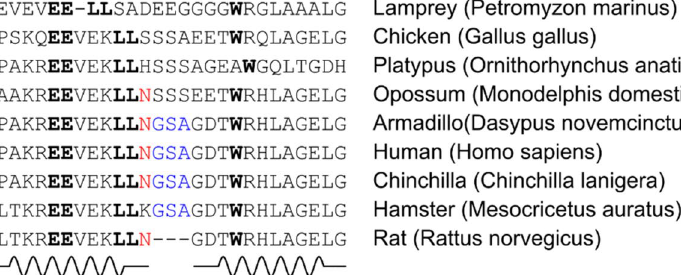
Figure 8. Sequence alignment of death domain fragments from different organisms. The highly conserved residues are in bold. The N352 is shown by red, GSA sequence by blue. The secondary structure of the rat p75NTR is shown under amino acid sequences. The phylogenetic tree (right) shows the evolutionary history of the DD fragment of the p75NTR gene, the numbers indicate the split time of species (in a million years, according to the Ensembl data: https ://www.ensem bl.org/Multi /GeneT ree/Image ?gt=ENSGT 00730 00011